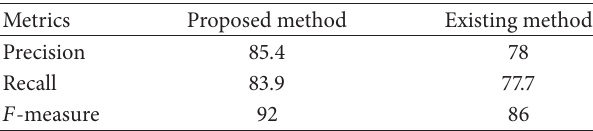
Table 4: Comparison of proposed Na¨ıve Bayesian classifier and existing method